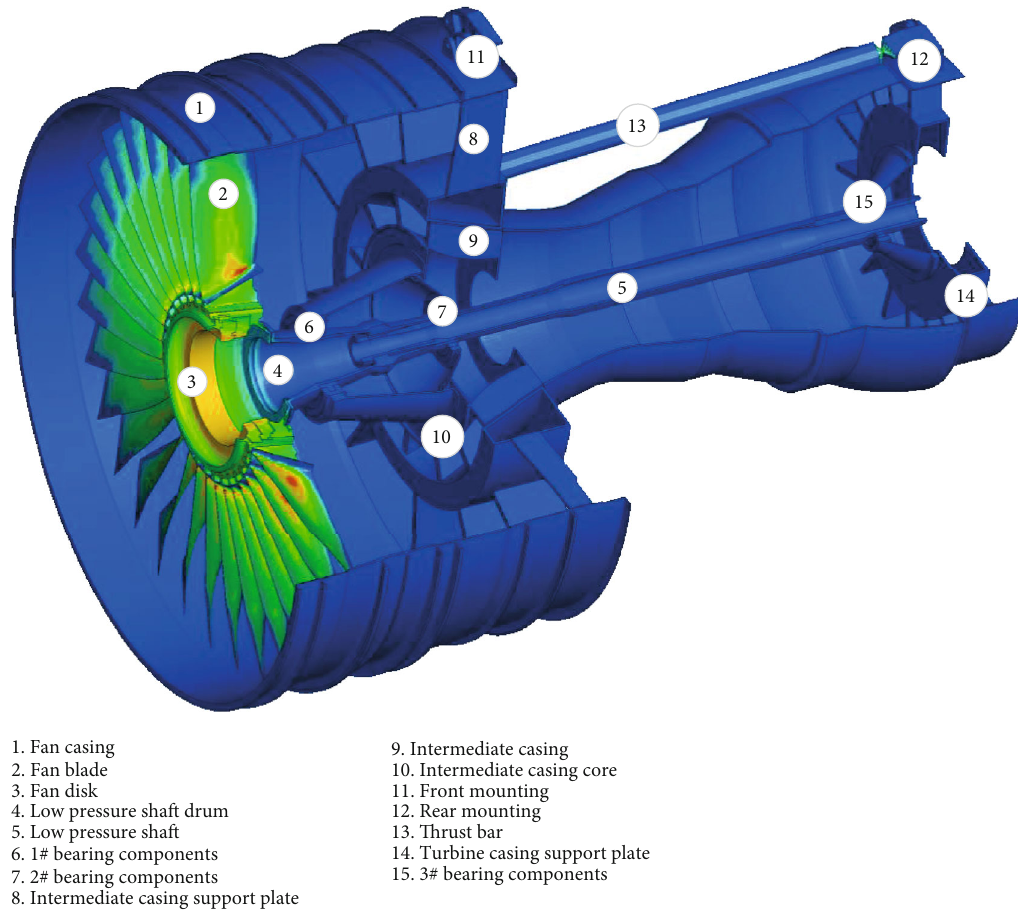
Figure 3: Geometric model pro fi le of the whole engine.